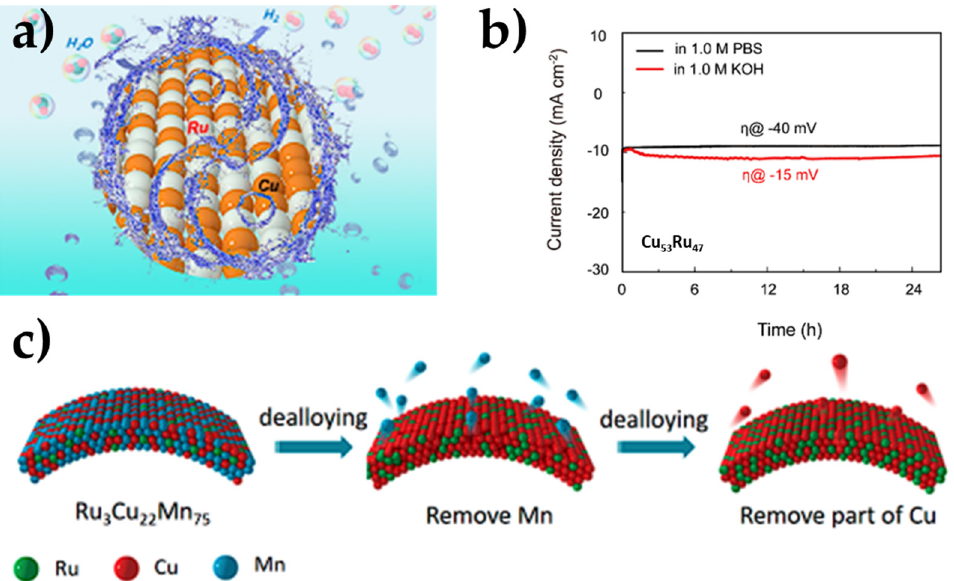
Figure 6. ( a ) Schematic representation of a stable alloy of CuRu nanoparticle for Hydrogen Evolution Reaction; ( b ) Stability tests of the Cu 53 Ru 47 in neutral (1M PBS) and in alkaline (1M KOH) environment; ( c ) Schematic illustration of the preparation procedure by dealloying a single − phase ternary Ru 3 Cu 22 Mn 75 precursor in (NH 4 ) 2 SO 4 solution to remove Mn. Reprinted with permission from [28]. Copyright 2022 American Chemical Society.